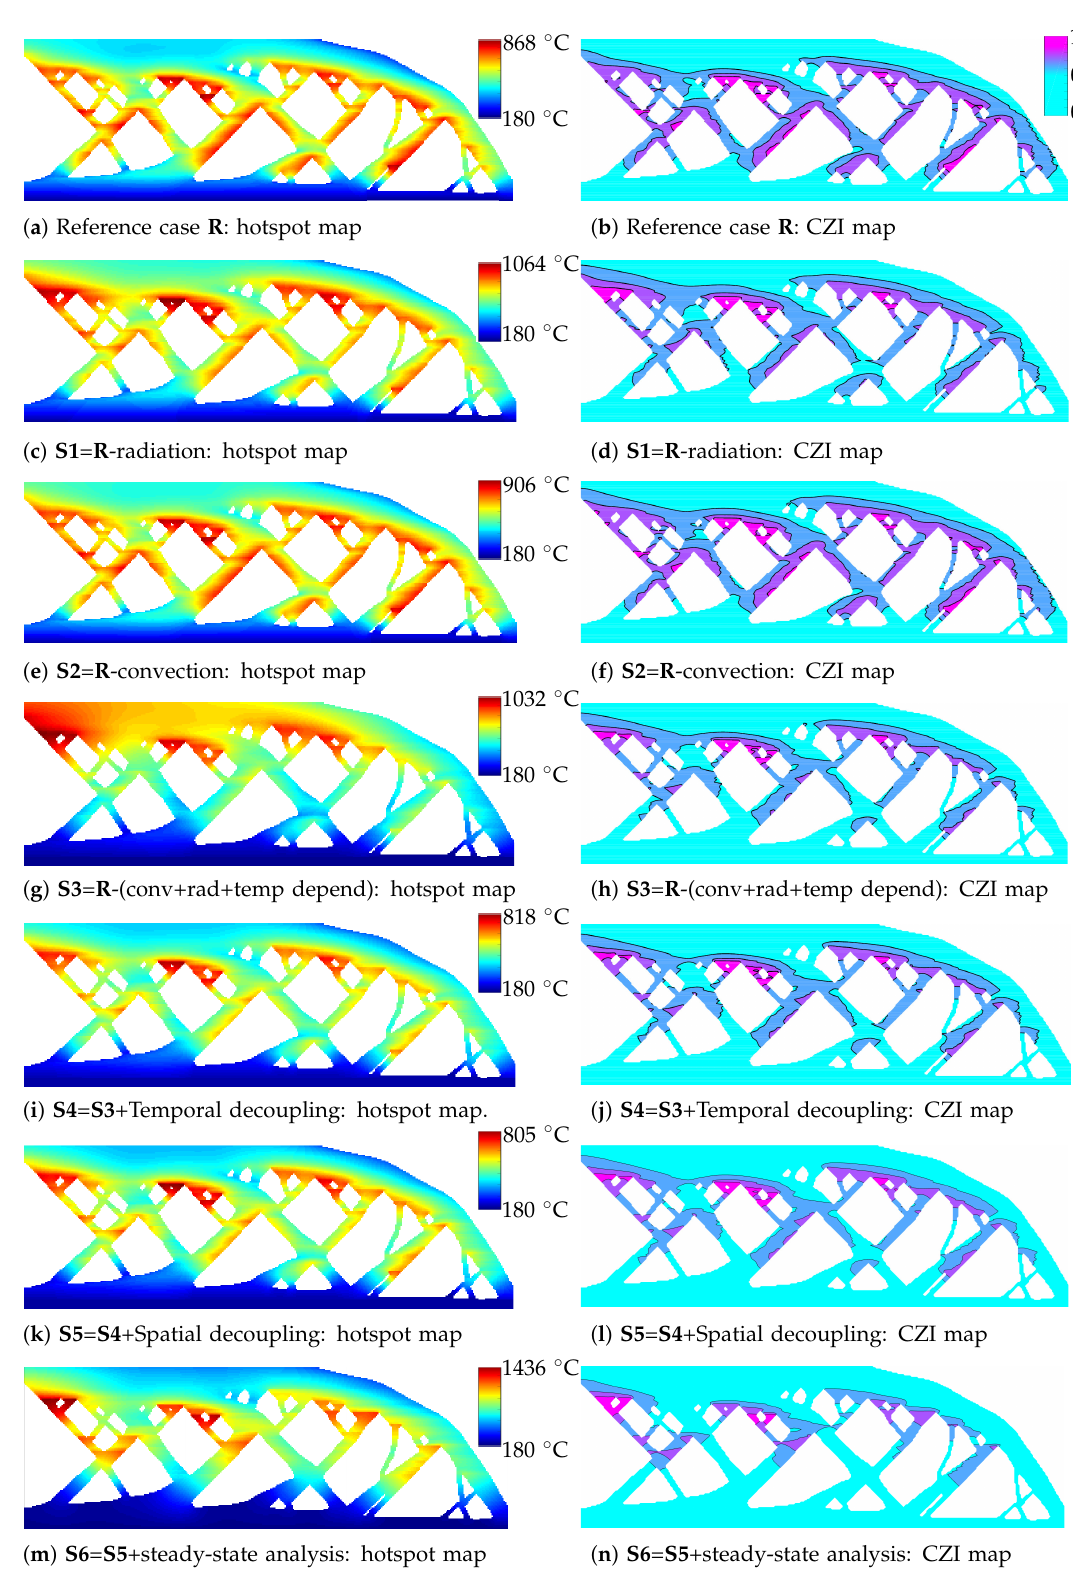
Figure 12. Peak temperature plots, i.e., the hotspot maps for different simplifications are presented in ( a , c , e , g , i , k ) and ( m ) while the CZI maps for different simplifications are presented in ( b , d , f , h , j , l , n ). Sub-captions are provided to specify the respective